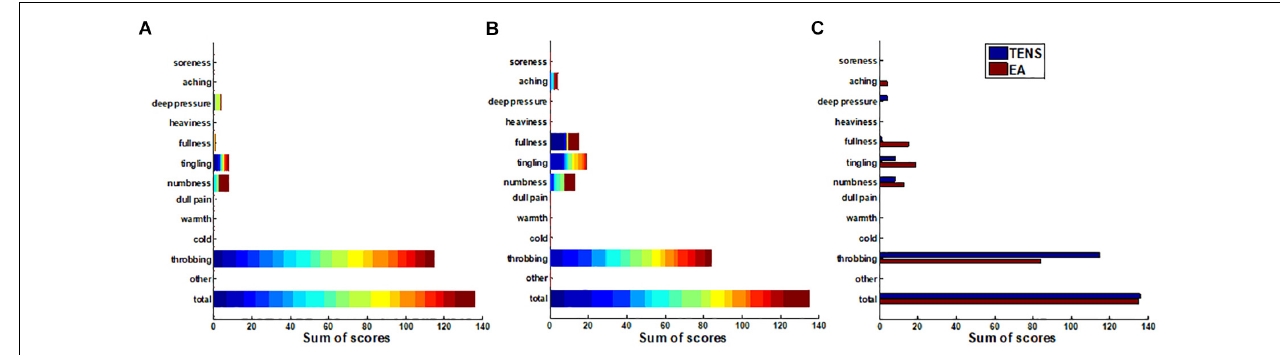
FIGURE 6 | The sums of the modified Chinese version of Massachusetts General Hospital Acupuncture Sensation Scales (C-MMASS) scores of all the subjects. Each bar represented the sum scores at a descriptor of all subjects. In (A,B) , each color of a bar represented a score of one subject. (A) TENS sum scores. (B) EA sum scores. (C) Comparison of sum scores between TENS and EA.